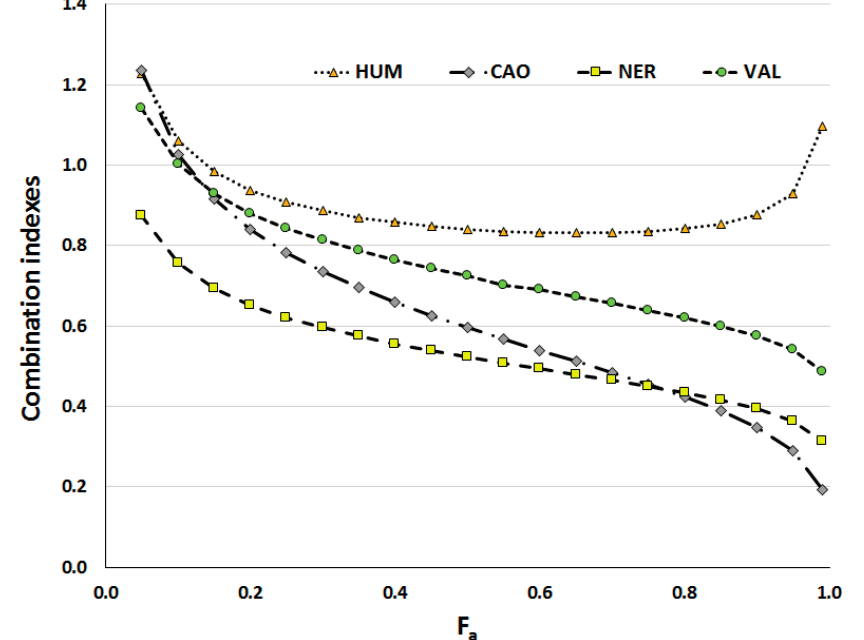
Figure 5. Combination indexes (CI) of DOX and sesquiterpenes in dependence on fraction of affected CaCo-2 cells (F a ). Incubations lasted for 72 h. Data were calculated using CalcuSyn